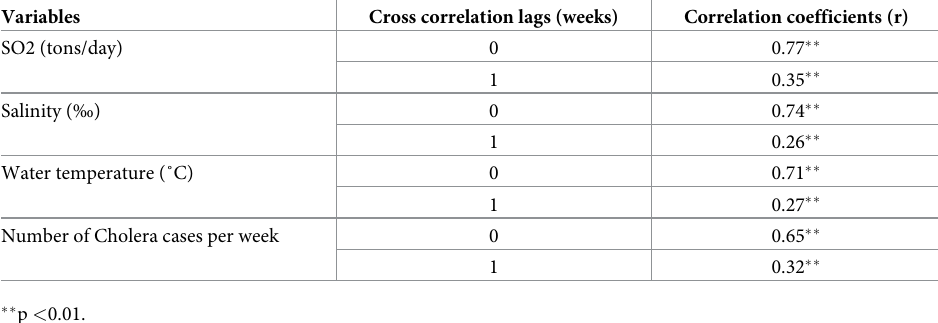
Table 8. Cross correlations between the concentration of V. cholerae in the Kivu lake. the number of cholera cases in the Katana health zone. and environmental variables over the 2016–2017 period (n = 48 sampled weeks).